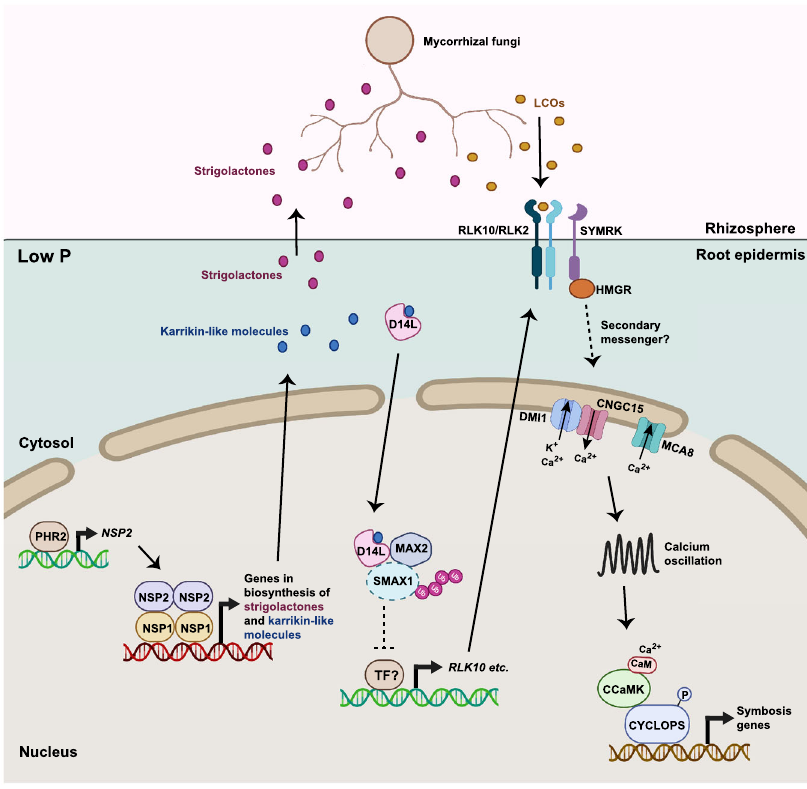
Fig. 7 | P-regulation of LCO production and perception, controlled by NSP1/ NSP2 . Under P-starvation conditions, NSP2 expression ispromoted by PHR2 32 , that functions with NSP1 to promote gene expression associated with the biosynthesis of strigolactones and unknown karrikin-like molecules. Strigolactones are exuded totherhizospheretoactivatehyphalbranchingof mycorrhizalfungiandstimulate theproductionoffungalsignals,includingLCOs 8 – 10 .Karrikin-likesignalingviaD14L removes SMAX1 suppression, allowing the expression of the LCO receptor,